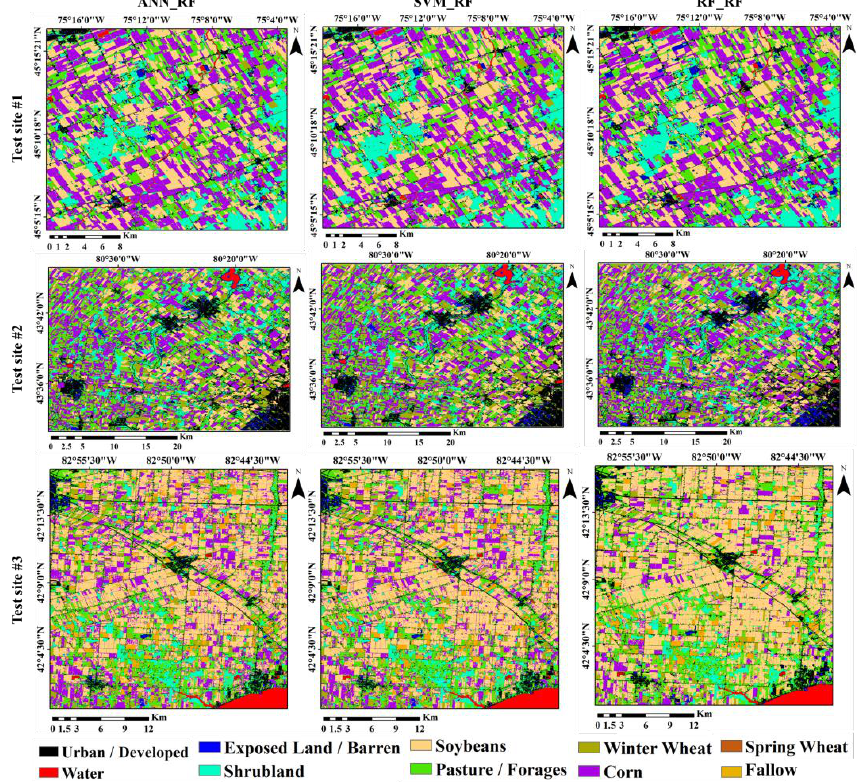
Figure 3. Samples of the land crop/cover maps derived from various scenarios for test site 1, 2, and 3.